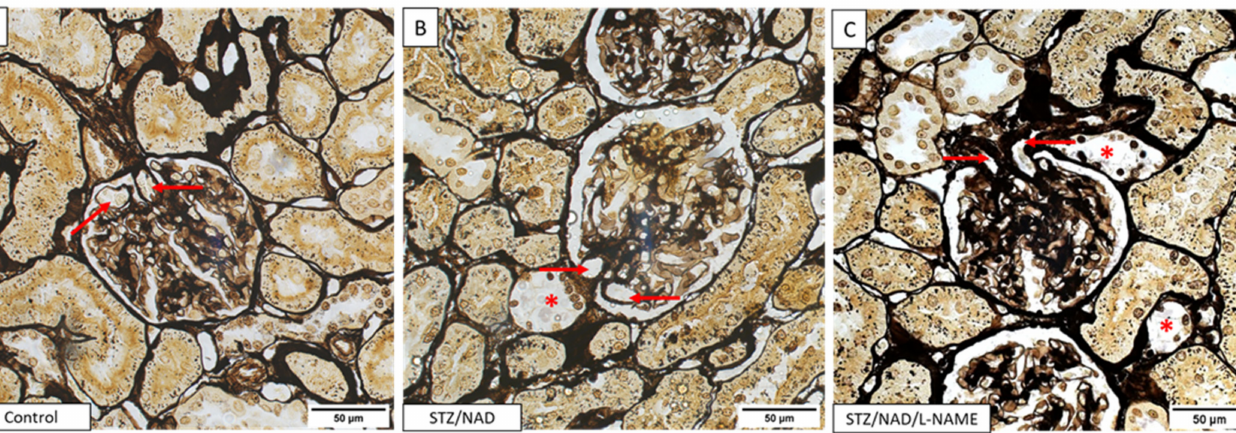
Figure 7. Jones methenamine silver-stained renal section of a non-diabetic control rat ( A ), STZ/NAD ( B ) and STZ/NAD/L-NAME ( C ) diabetic rat at week 12. Glomeruli of the diabetic rat show mild mesangial expansion (#) and diffuse thickening of capillary walls (dashed arrow). Tubular lesions manifested as tubular epithelial cell necrosis (asterisk) and tubular atrophy (arrow).